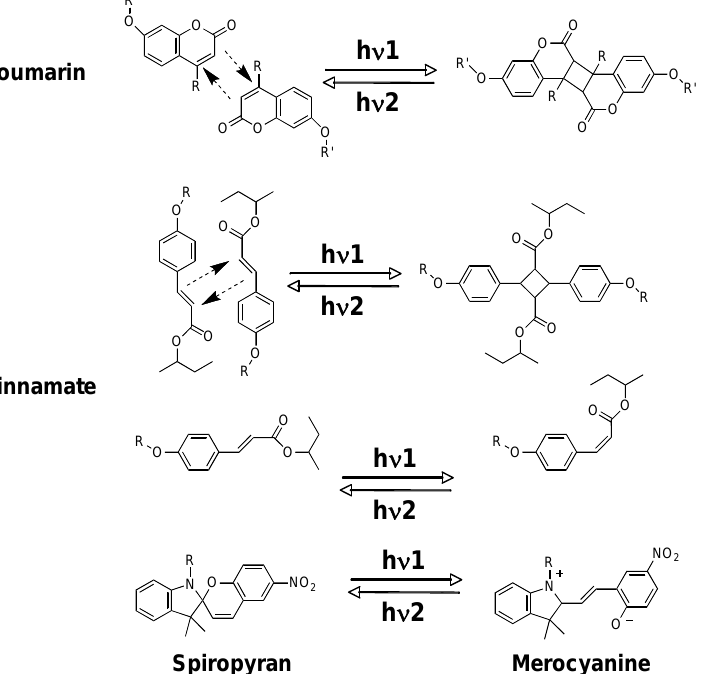
Figure 7. Photoresponsive properties of coumarin, cinnamate and spiropyran derivatives.